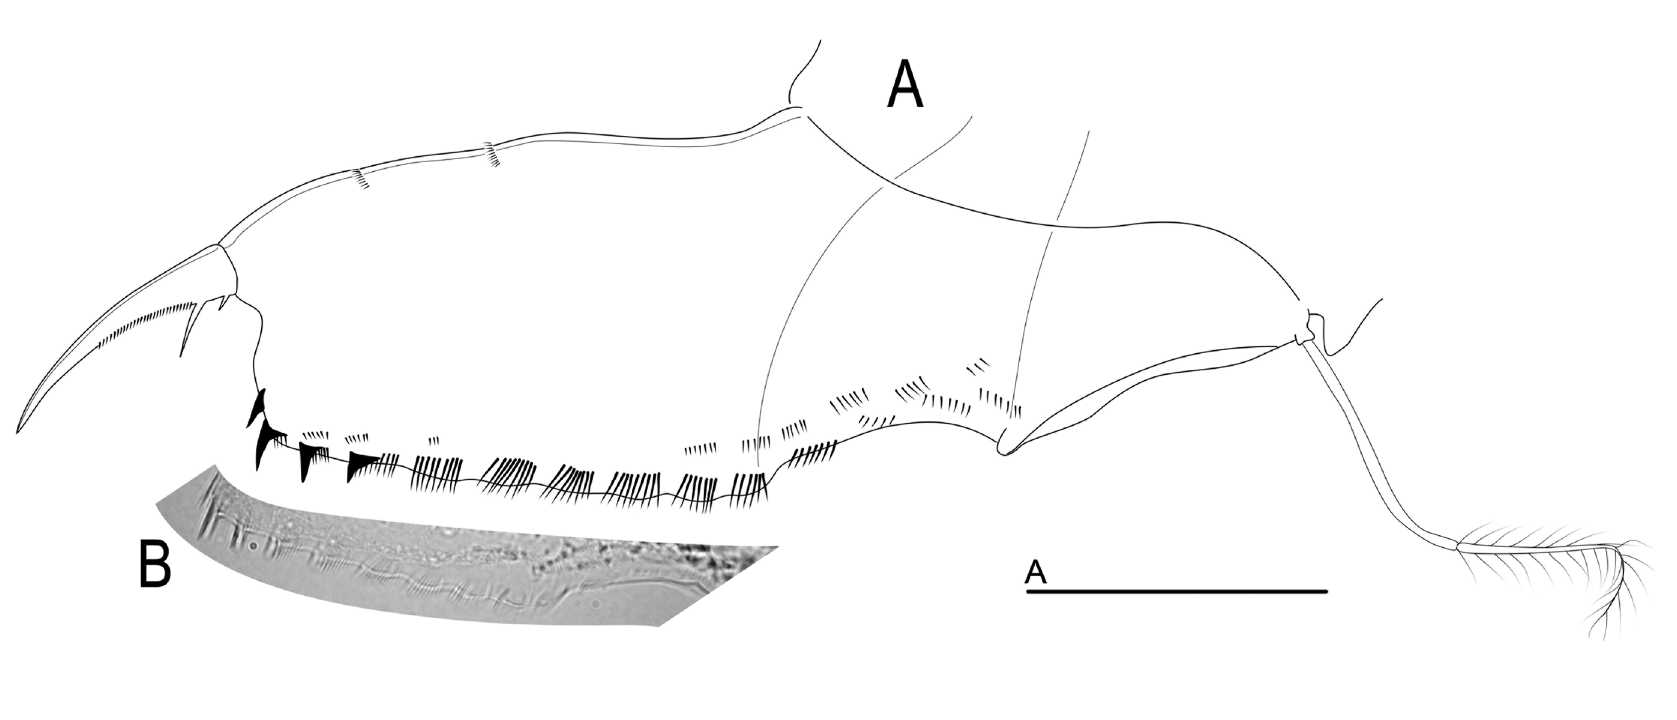
Fig. 12. Disparalona ( Mixopleuroxus ) tenuispina sp. nov., parthenogenetic female. A–B . Postabdomen. A . Lateral view. B . Marginal denticles. Scale bar = 50 μm. Fig. B was not